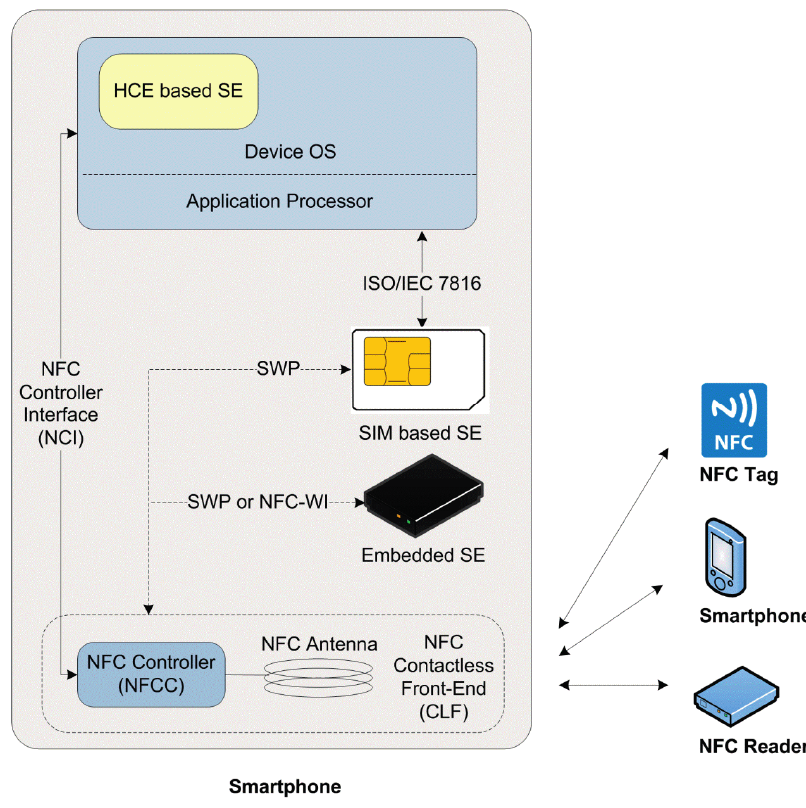
Figure 2. General architecture of a NFC